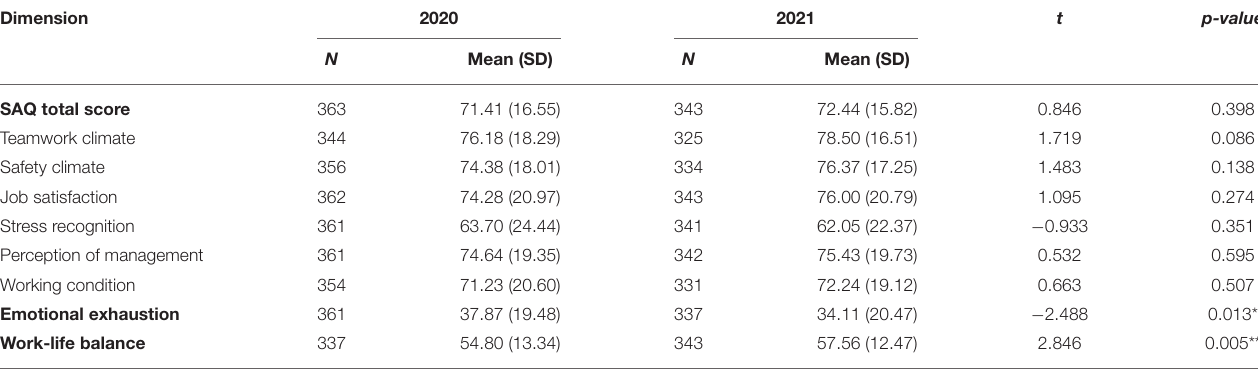
TABLE 3 | SAQ, EE, and WLB (2020 vs. 2021).